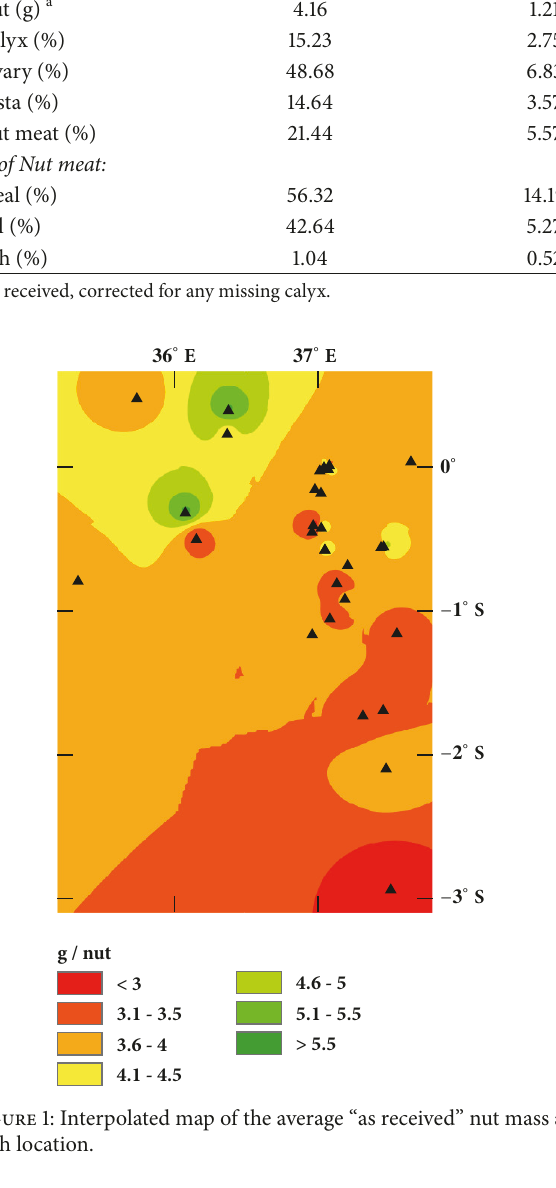
Figure 3: ATR-FTIR spectrum of Croton oil from Sipili, Kenya, before baseline subtraction and normalization to the C=O stretch at 1743 cm - 1 attributed to the ester carbonyl of the